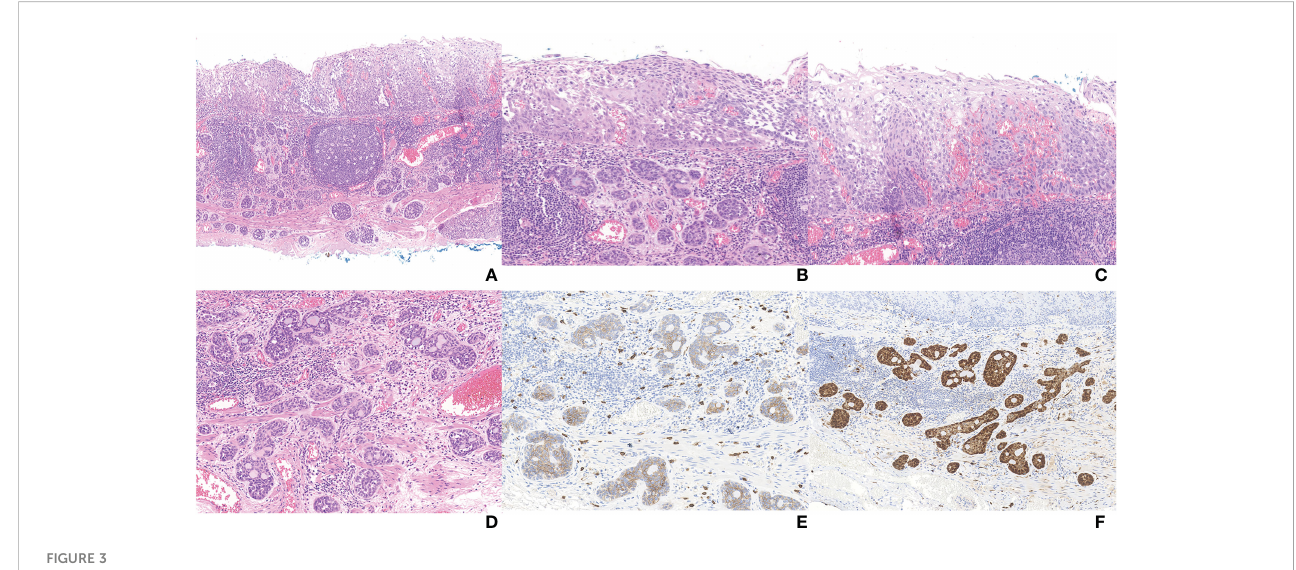
FIGURE 3 (A) Full view of collision carcinoma; (B) Area of collision between SqCC (up) and AdCC (down); (C) Area of SqCC; (D) Area of AdCC; (E) Immunohistochemical staining of AdCC (CD117); (F) Immunohistochemical staining of AdCC